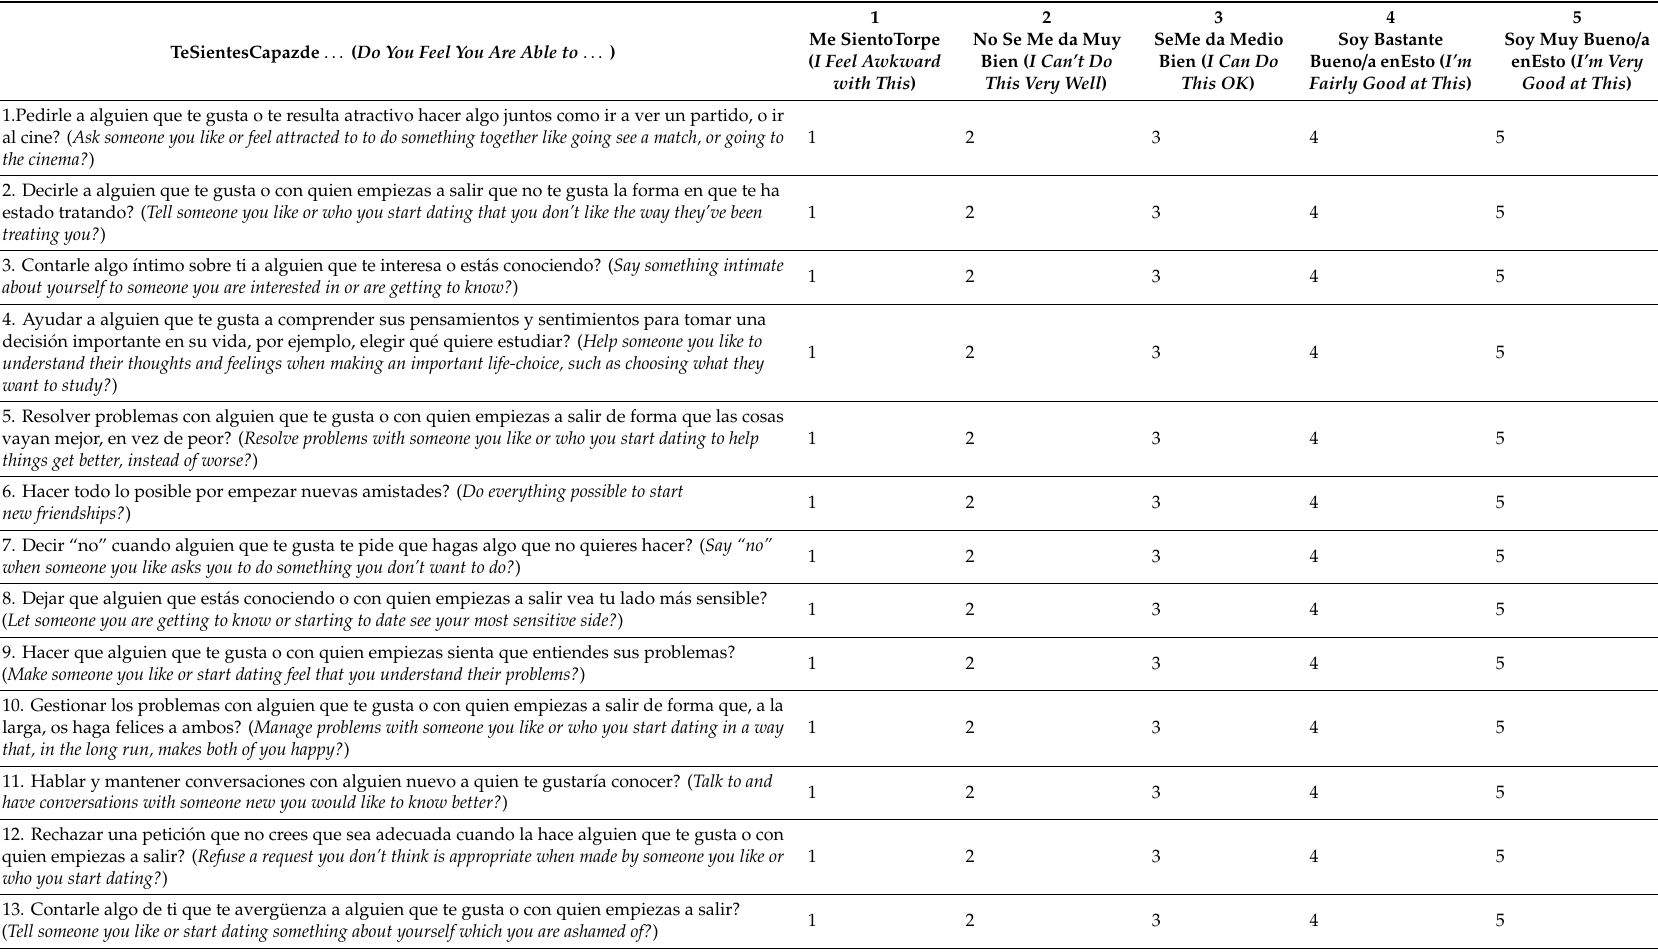
Table A1. Adolescent Interpersonal Competence Questionnaire for